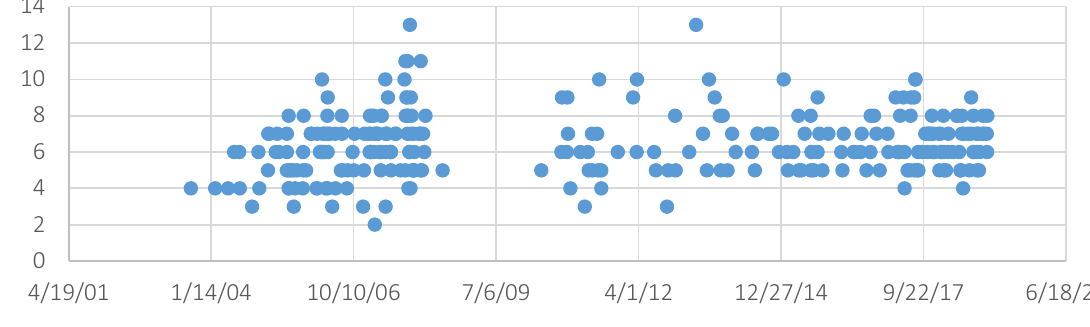
Figure 2. Number of promoters